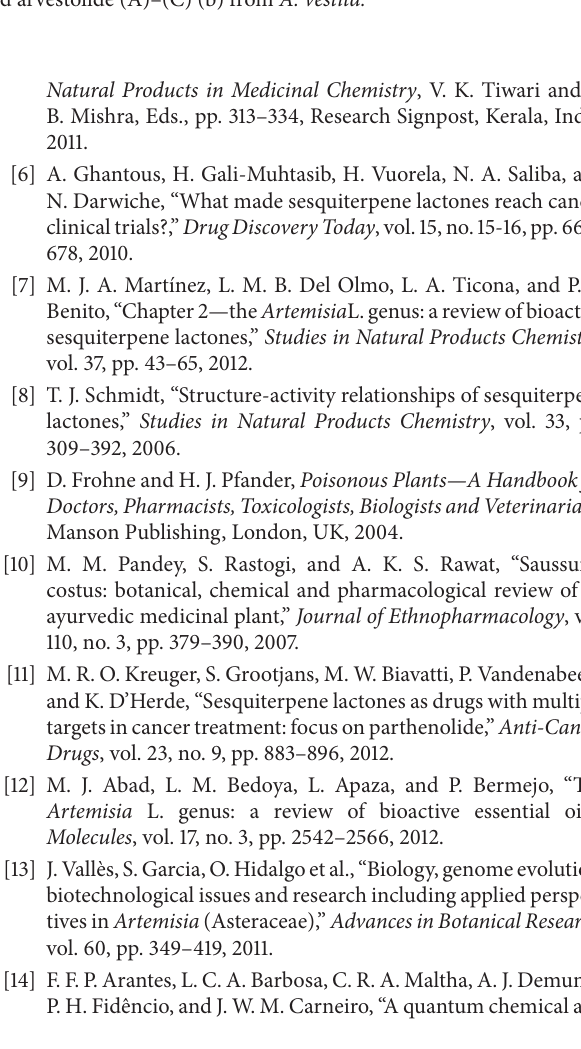
Figure 3: Artemivestinolides (A)–(C) (a) and arvestolide (A)–(C) (b) from A.